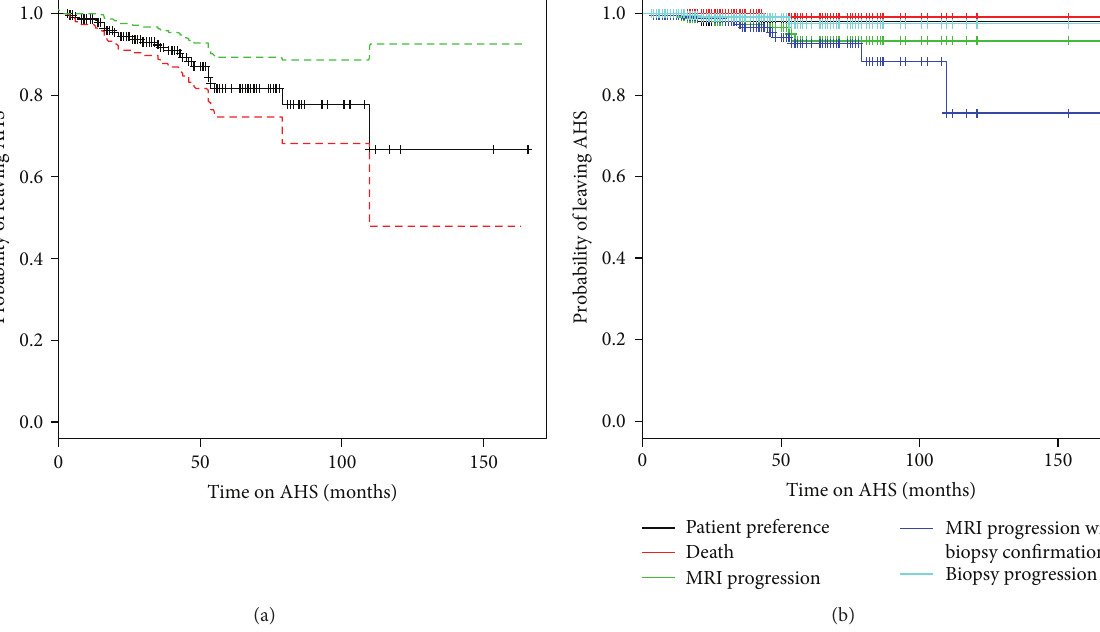
Figure 3: Kaplan-Meier survival curves. (a) The overall likelihood of patients remaining on AHS cohort (key: solid black line represents the probability; red and green lines represent the standard deviation of the curve). (b) The likelihood of patients remaining on AHS stratified by the reasons for